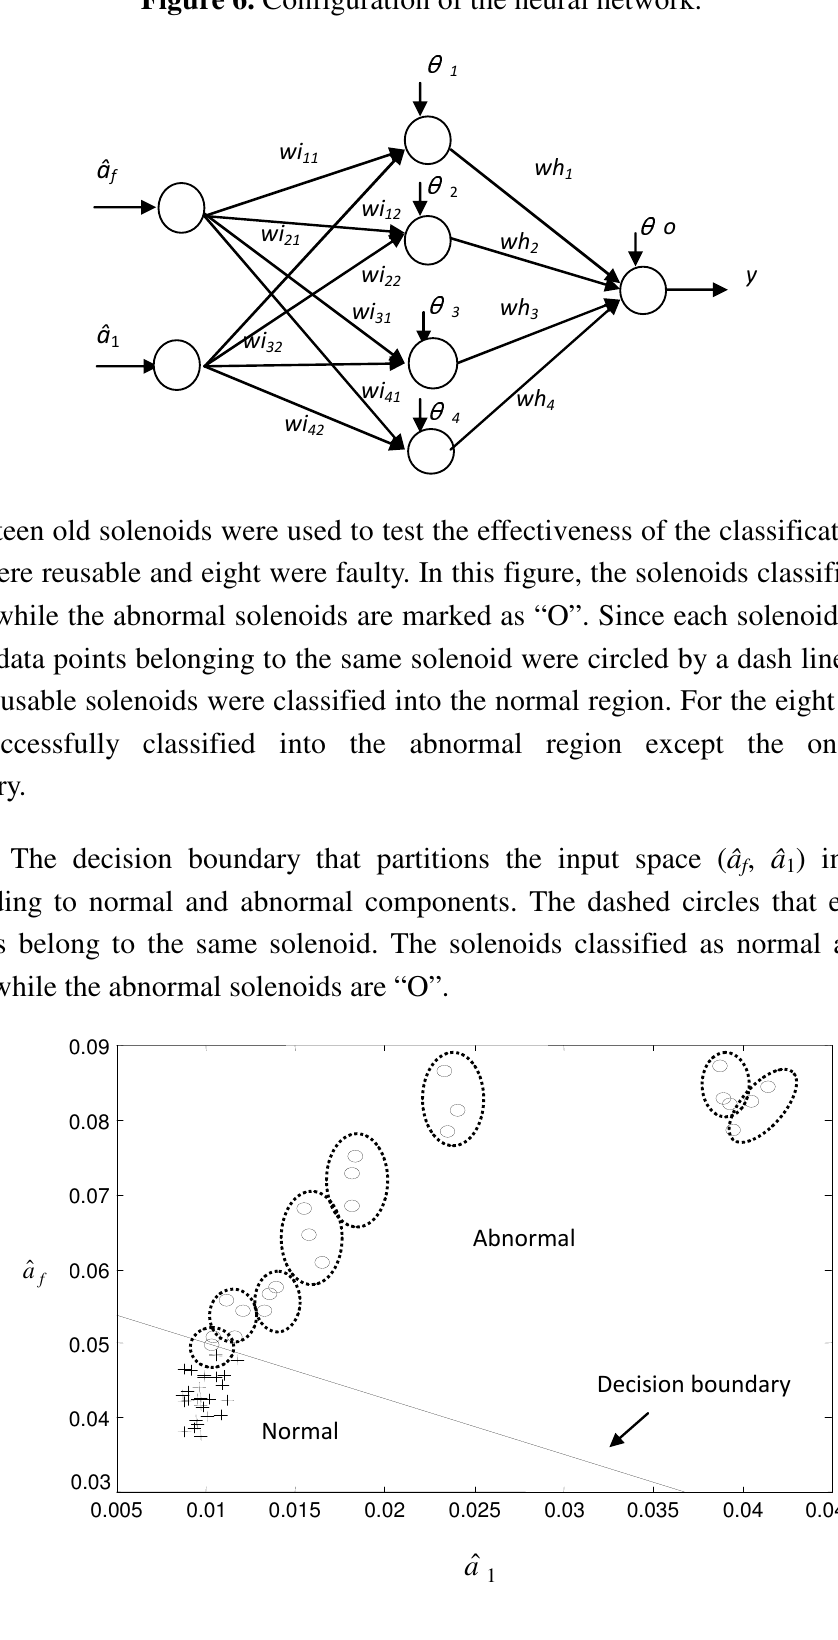
Figure 6. Configuration of the neural network.